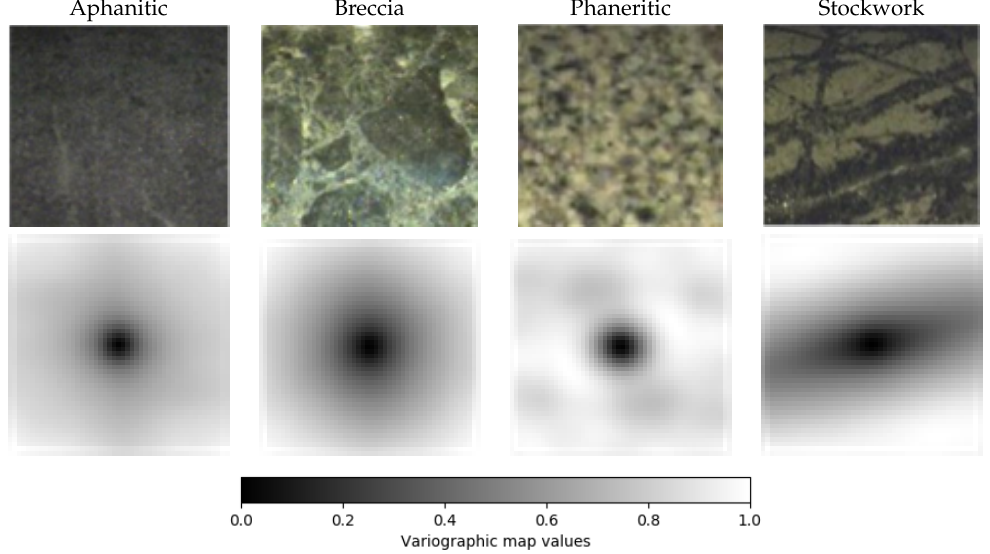
Figure 2. Original images in RGB color space from different classes of rock texture ( top ) and their corresponding variographic maps with colormap ( bottom ). Each variographic map (zoomed 2 × ) denotes the spatial continuity information present in the texture using normalized grayscale—from dark tones (low variogram values) to light tones (high variogram